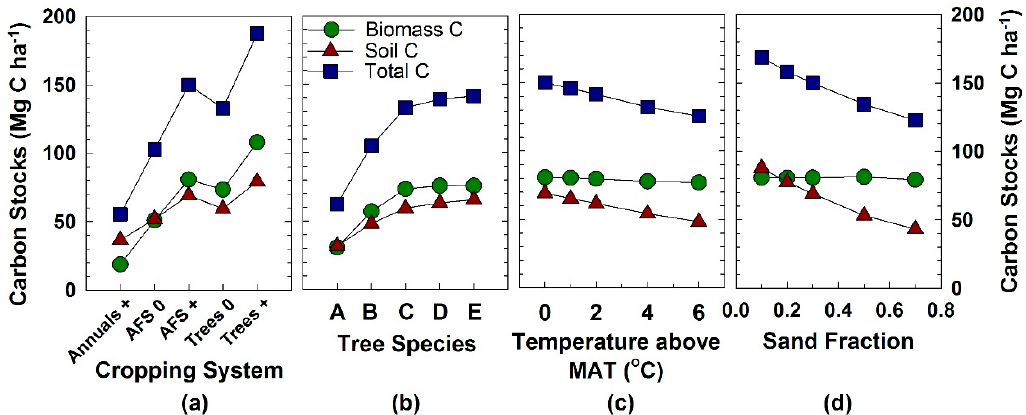
Figure 1. Simulated C stocks in four modeling experiments. ( a ) Experiment 1, regarding the effect of cropping system. The five treatments either received ( + ) or did not receive (0) organic matter (OM) additions and irrigation. ( b ) Experiment 2, regarding the effect of tree species. Lignin content in modeled tree species (A–E) increased from 0.25 to 0.45 in woody tissues, 0.05 to 0.25 in leaves, and 0.18 to 0.36 in fine roots. See Table S3 for tissue lignin fractions (variables WDLIG (1–5)). ( c ) Experiment 3, regarding the effect of increases in air temperature above the mean annual temperature (MAT). ( d ) Experiment 4, regarding the effect of soil type. Soil C values were for a 0–50 cm depth.